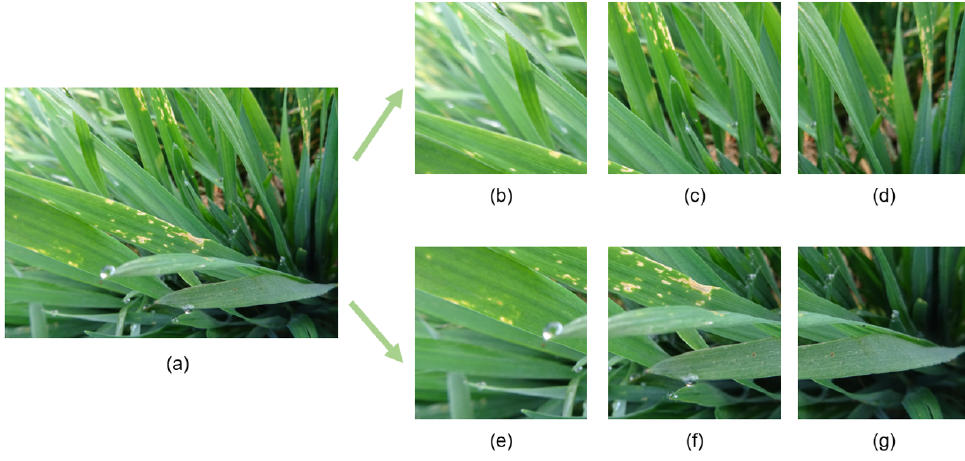
Figure 3. The example of image segmentation: ( a ) original image; ( b – g ) segmented